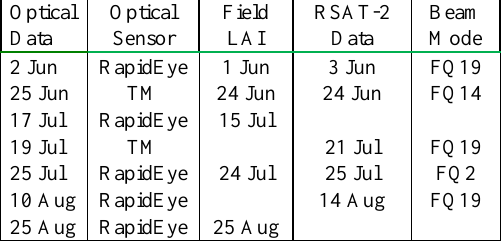
Table 1. Data acquired during AgriSAR